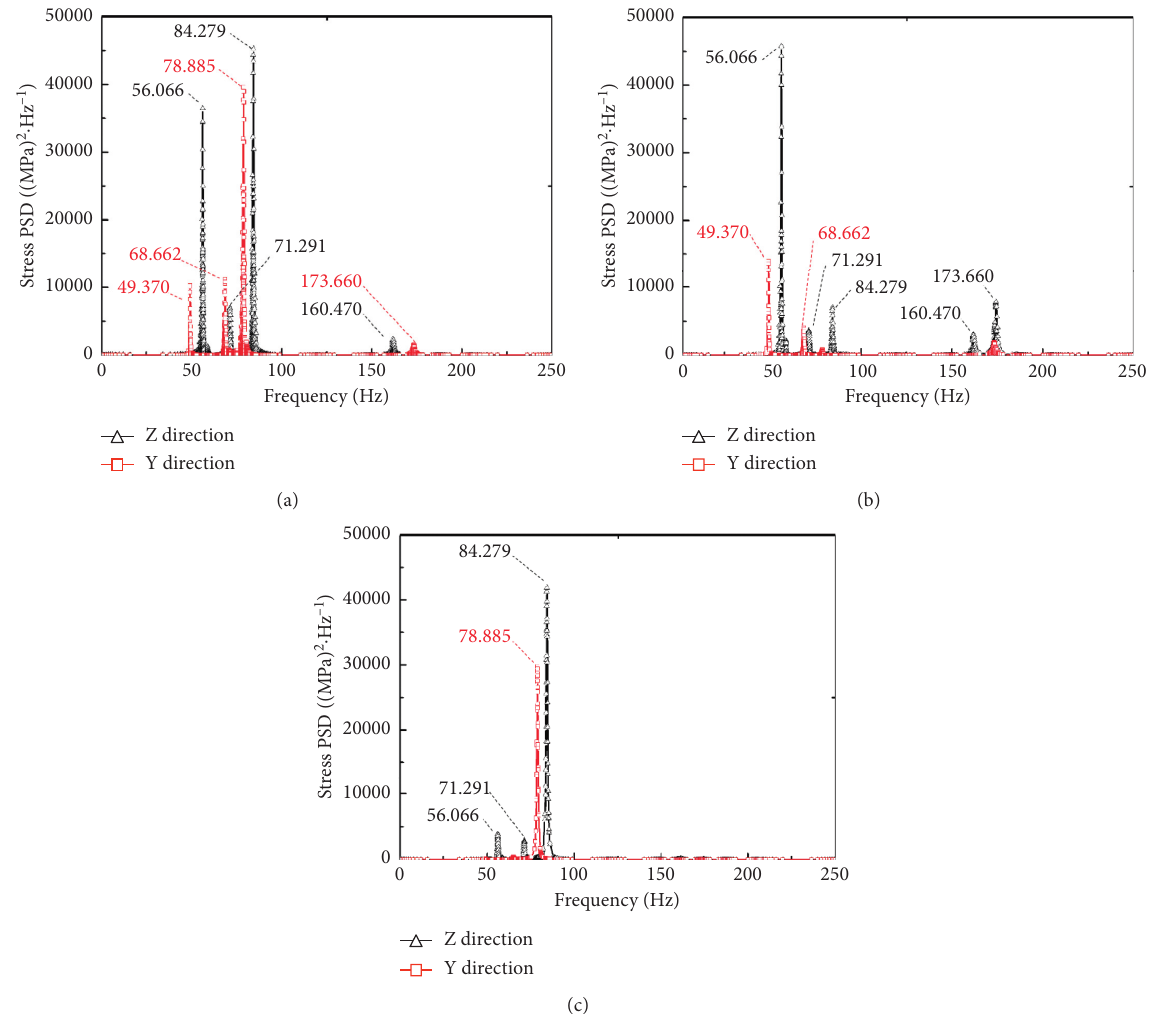
Figure 10: (a) Dynamic stress response of P1. (b) Dynamic stress response of P2. (c) Dynamic stress response of P3.